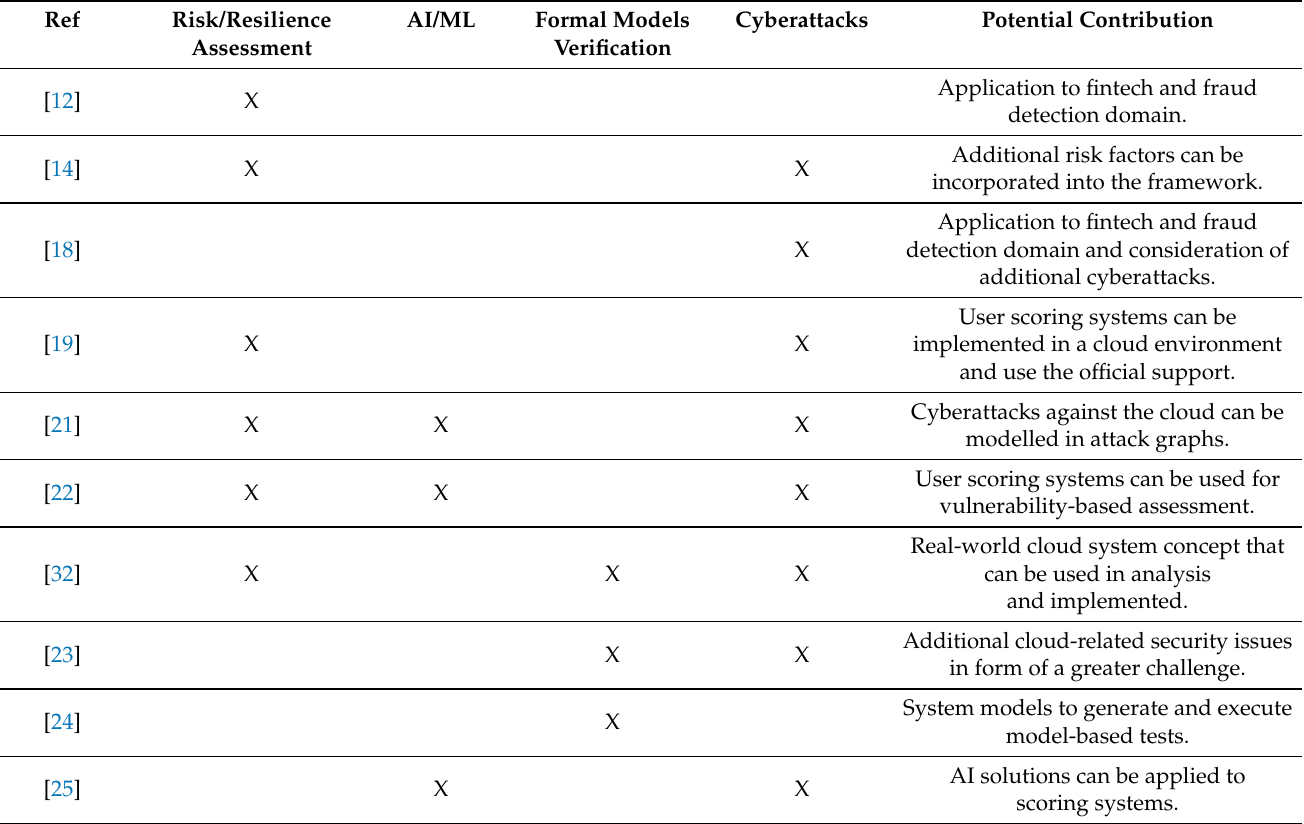
Table 1. Comparative table with potential